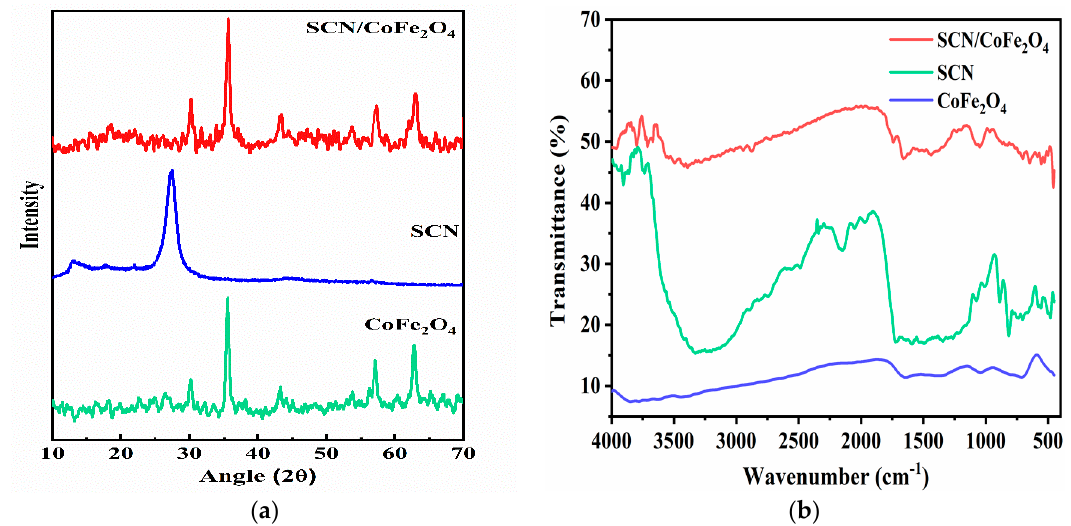
Figure 1. ( a ) XRD patterns of CoFe 2 O 4 , SCN, and SCN/CoFe 2 O 4 nanocomposite; ( b ) FT-IR spectra of CoFe 2 O 4 , SCN, and SCN/CoFe 2 O 4 nanocomposite.